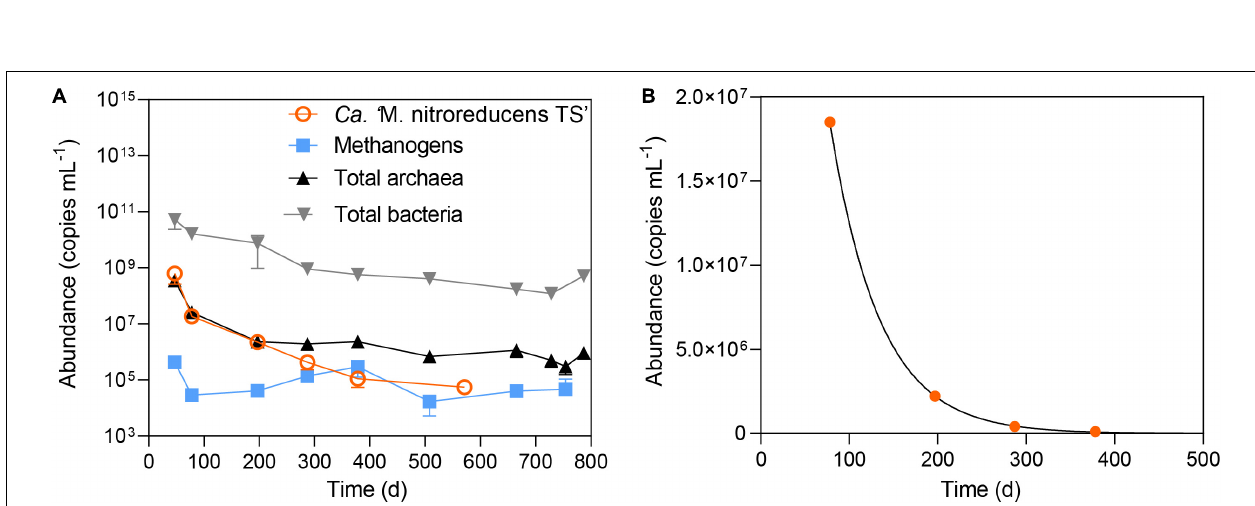
FIGURE 4 | (A) The abundance of total archaea, total bacteria, methanogens, and Ca. “ M. nitroreducens TS” throughout the incubation period. (B) Measured abundance of Ca. “ M. nitroreducens TS” fitted with kinetic growth